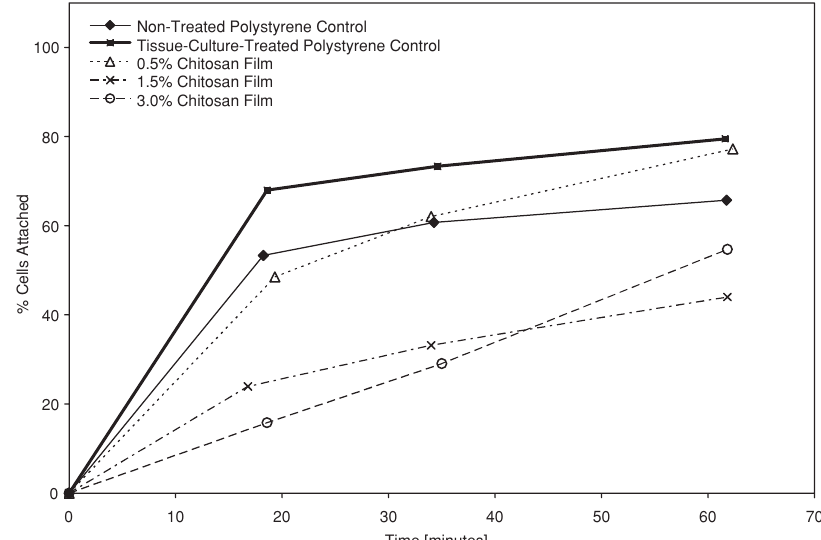
Figure 3 Cell attachment on chitosan films and polystyrene controls. Each point represents at least three different tests, maximum error